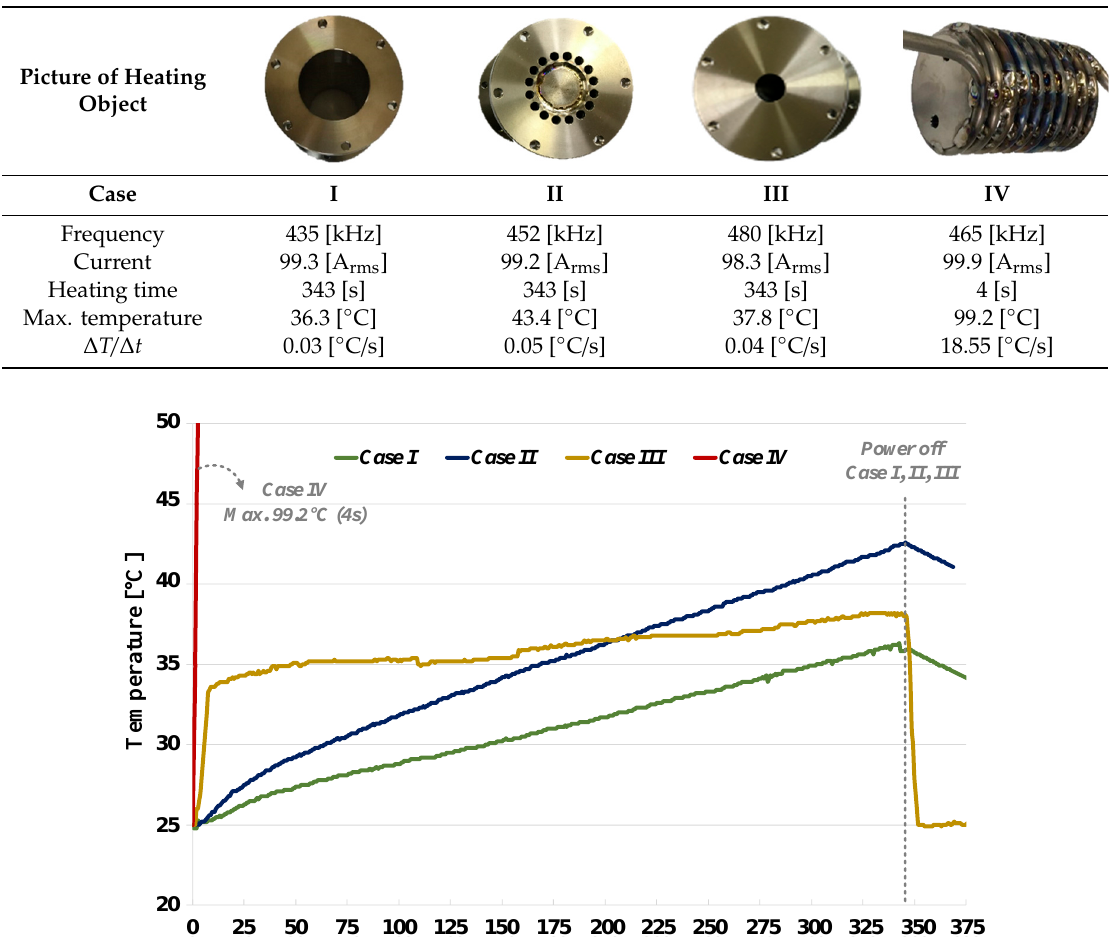
Figure 15. Experimental results of temperature rise for each Ti load case.